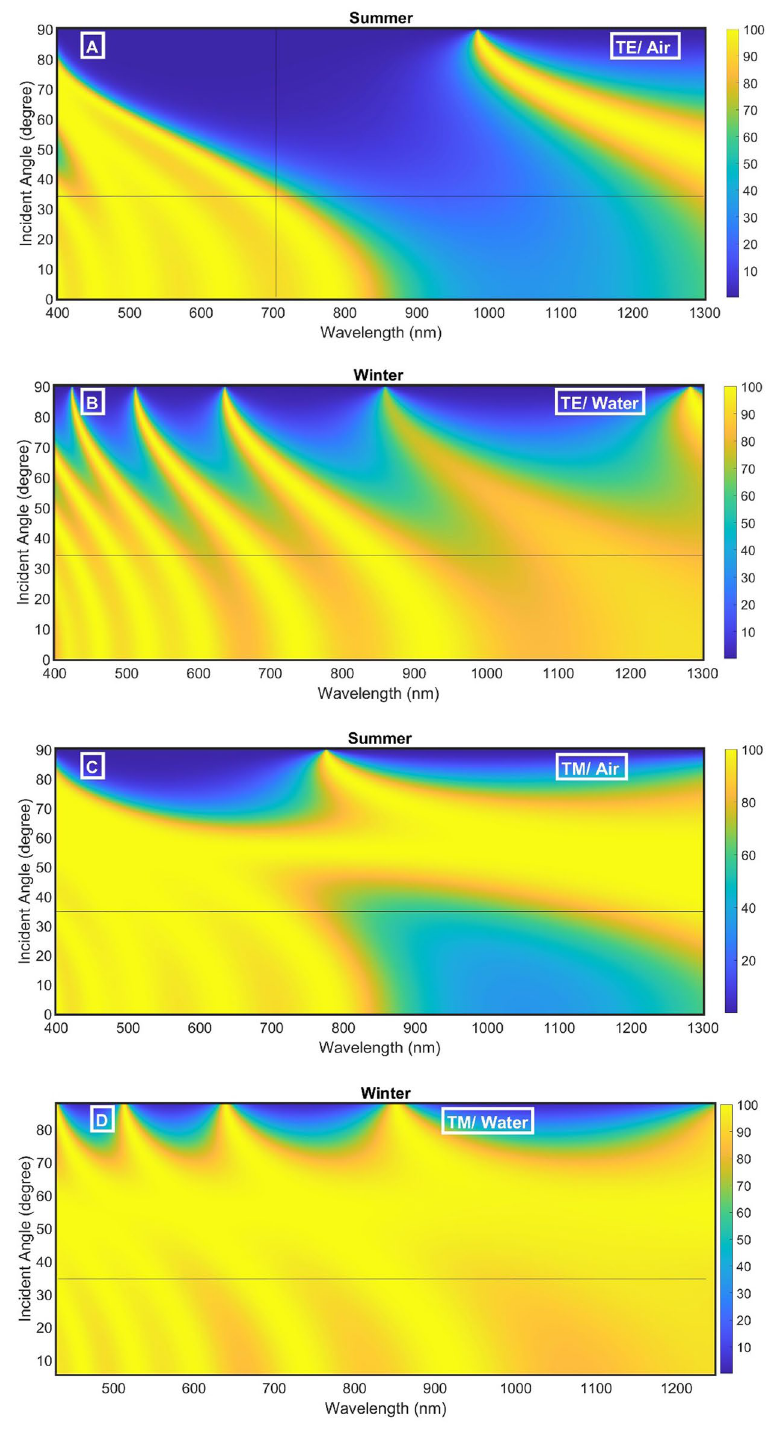
Figure 3. The transmittance of the proposed smart windows at initial conditions as a function of the incident angle ( A ) TE/Air, ( B ) TE/water, ( C ) TM/Air, and ( D )